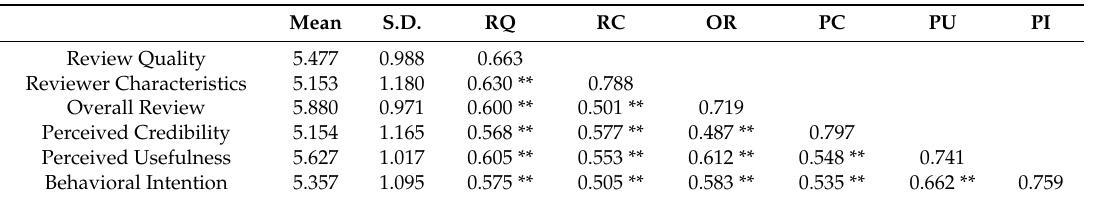
Table 4. Summary of correlation